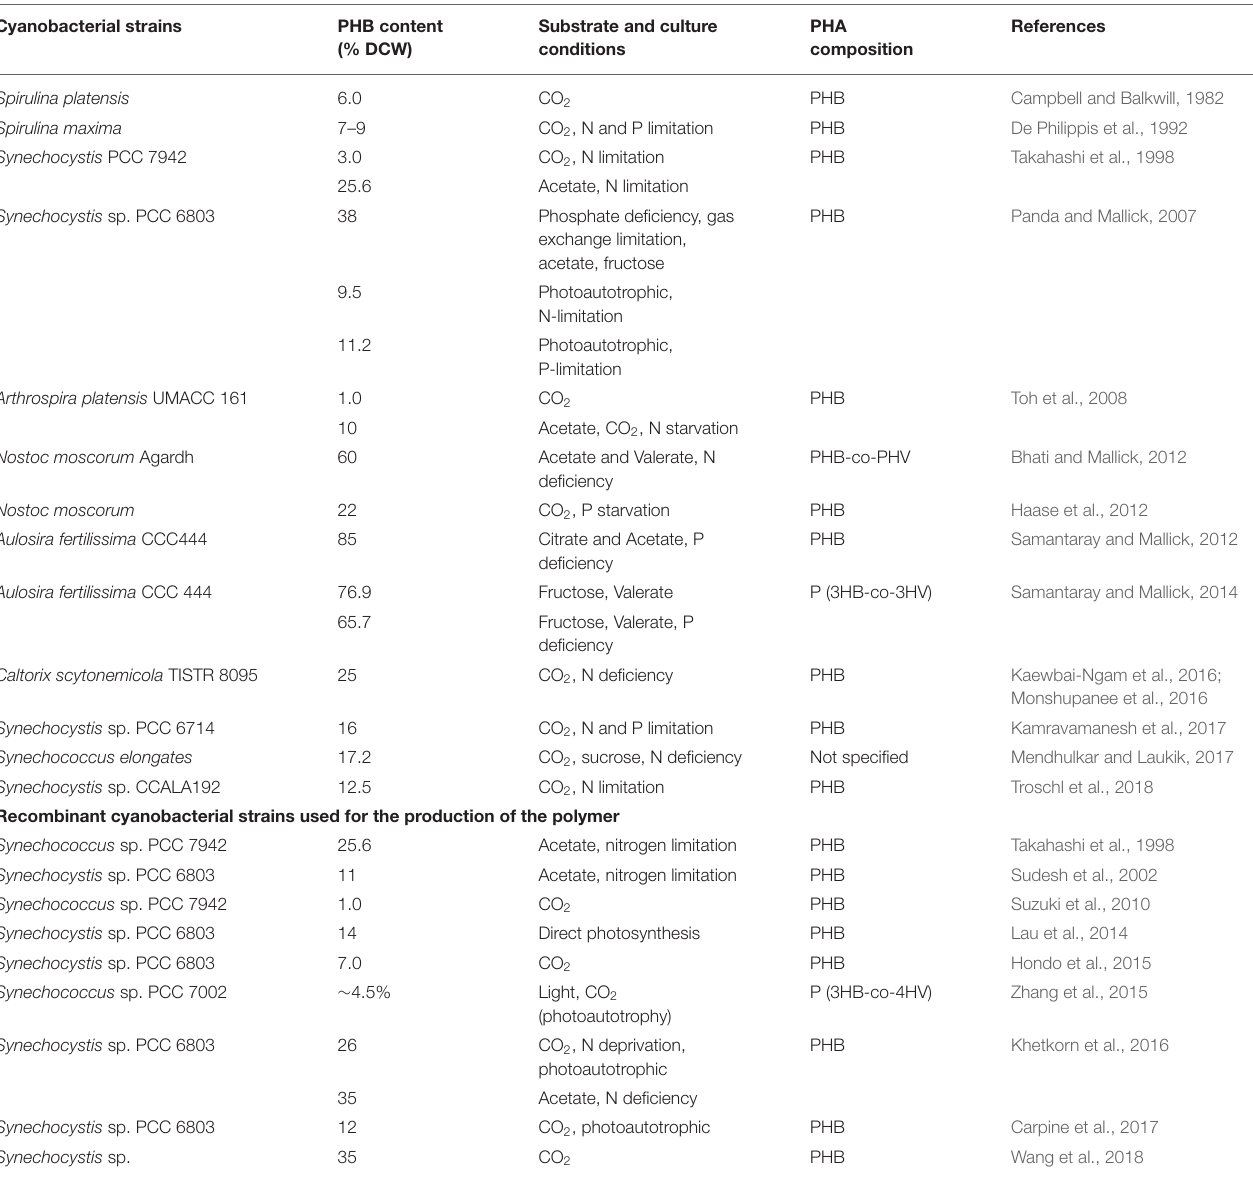
TABLE 2 | List of wild-type and recombinant cyanobacterial strains used for the production of polymers. Cyanobacterial